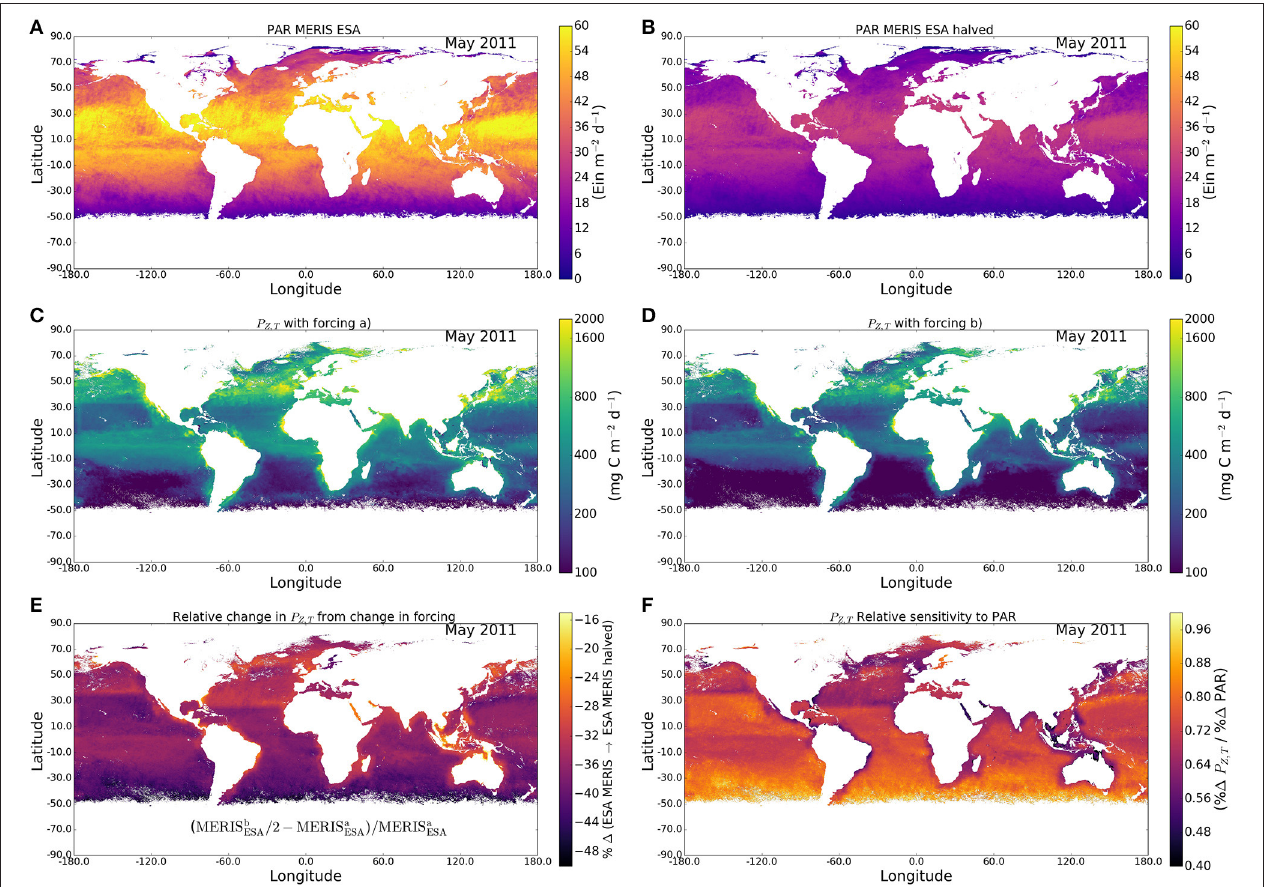
FIGURE 3 | Effect on daily, watercolumn production of a 50% reduction in surface irradiance for May 2011. (A) Surface PAR field before reduction; (B) Surface PAR field after reduction; (C) daily production before reduction of surface light; (D) daily production after reduction of surface light; (E) relative change in primary production following reduction of surface light; and (F) relative change in primary production following reduction of surface light, normalized to the relative change in surface